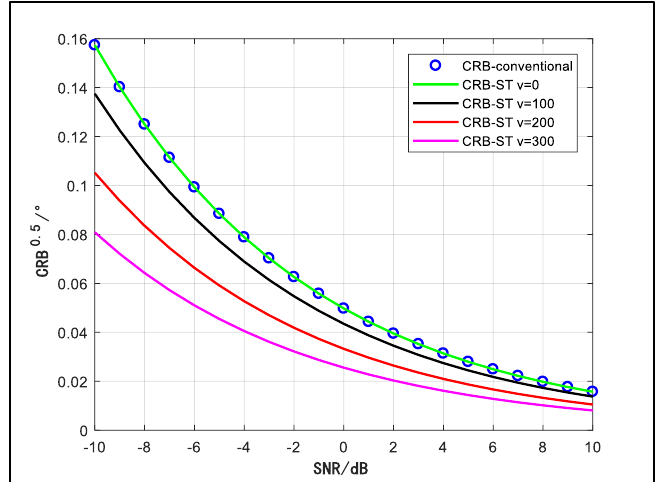
Figure 5. CRB versus SNR for different values of the velocity.